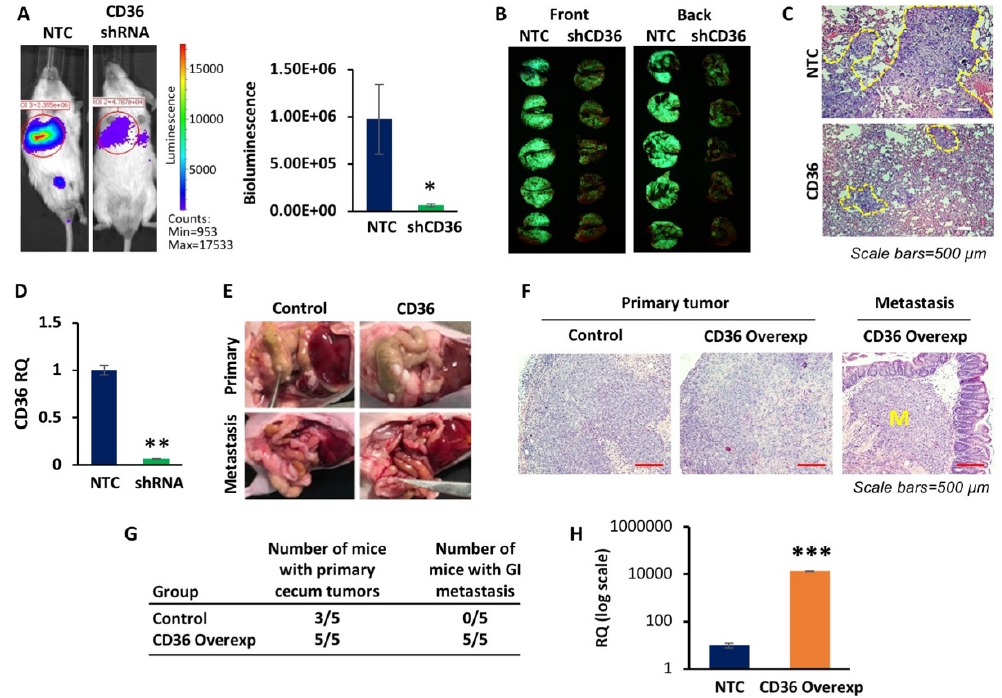
Figure 3. CD36 promotes lung colonization and metastasis in vivo. ( A ) Representative images and quantification of the bioluminescence imaging in tail-vein-injected mice of HT29 LuM3 GFP-Luciferase cells, NTC ( n = 5) and CD36shRNA ( n = 5). ( B ) GFP imaging and ( C ) H&E staining of lung tissues of resected lungs of the tail-vein-injected mice. ( D ) qRT-PCR quantification of CD36 in the HT29 LuM3 GFP-Luciferase NTC and CD36sh RNA cell lines. ( E ) Images from the HCT116 control and CD36 overexpression cecum-injected mice, showing increased tumor burden and colon metastasis in the CD36 overexpression mice. ( F ) Hematoxylin and eosin staining of the resected primary and metastatic tissues from mice injected with control and CD36 overexpression HCT116 cells. M—metastasis. ( G ) The rate of occurrence of primary cecum tumor and GI metastasis in mice based on gross examination. ( H ) qRT-PCR quantification of CD36 in the HCT116 p-Lenti-Control and CD36-Overexpression cell lines. * p < 0.05, ** p < 0.01, *** p < 0.001;